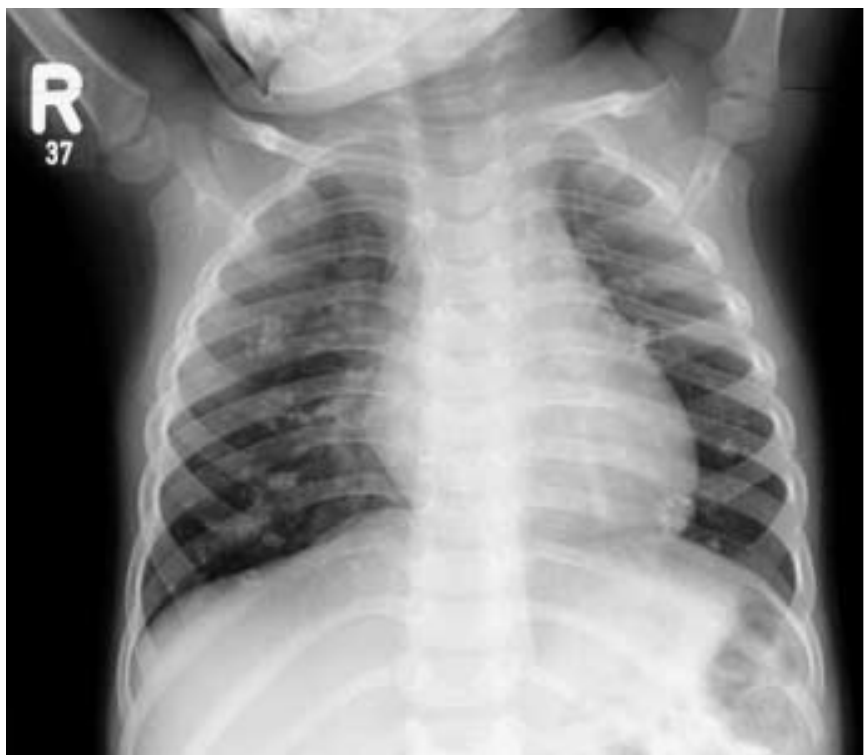
Chest x-ray showing scattered calcifica-